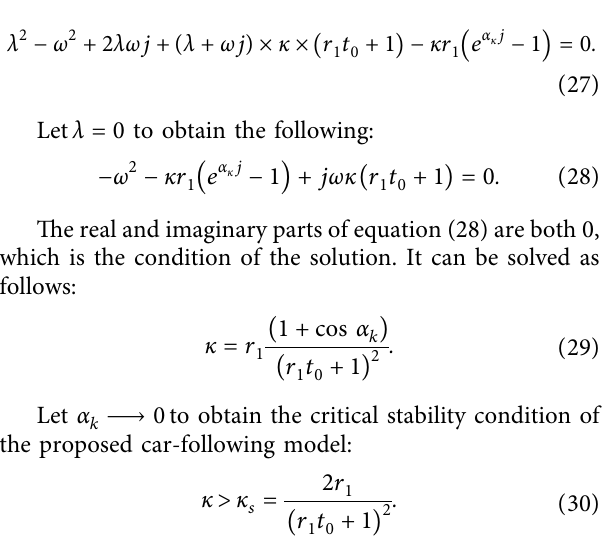
Figure 2: Critical stability curves for the different models: the parameter of the OVM is h c � 2; the parameters of the DSDM are t � 0 , 0 . 5 , 0 . 7 , 1 . h v when 0